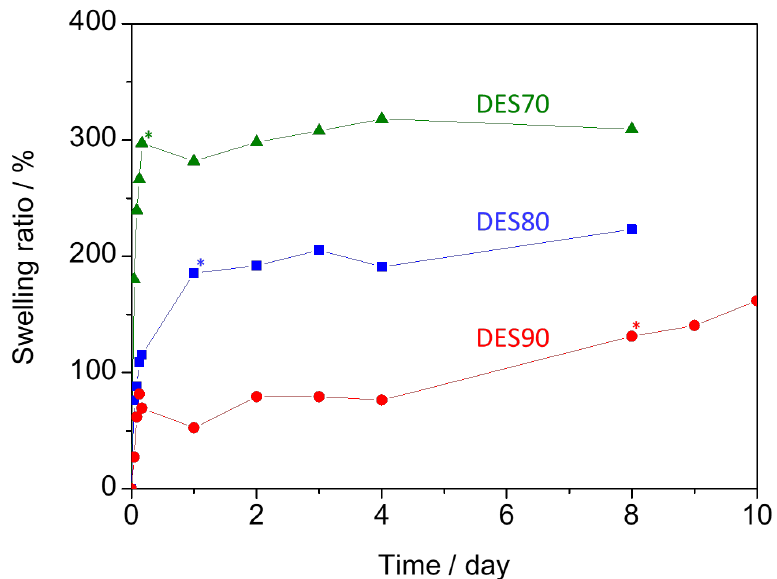
Figure 1. Swelling ratio of cellulose-based membrane in DES70 (triangle), DES80 (square), and DES90 (circle).